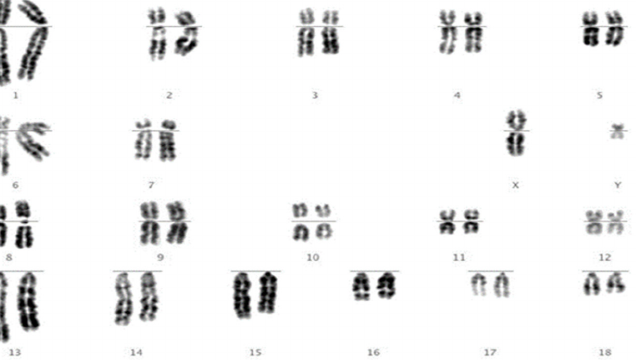
Figure 3 . Traditional banded metaphase chromosomes of a boar identified as carrying a reciprocal translocation of chromosomes 9 and 12. After analysis of ten metaphases, even with prior